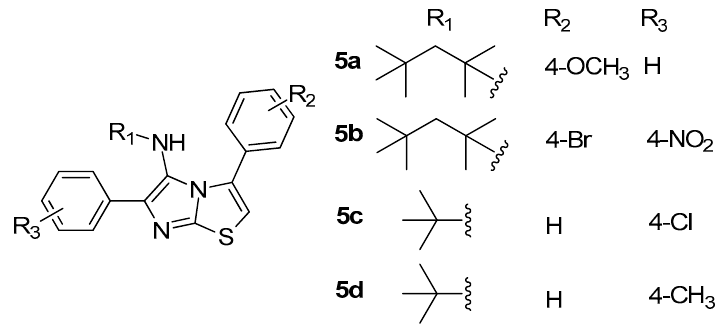
Figure 6. Chemical structures of 3,6-diphenylimidazo[2,1-b]thiazol-5-amine derivatives 5a – 5d . Elachkar et al. [77] designed and synthesized two novel thiazole derivatives (Figure 7), namely compound 6a (N-[4-(4-hydroxy-3-methoxyphenyl)-1,3-thiazol-2-yl]acetamide) and compound 6b (4-(2-amino-1,3-thiazol-4-yl)-2-methoxyphenol), with aim to analyze their effect on COX isoforms. It was shown, using cell-stably over-expressing COX-1 and blood platelets, that compound 6a was a non-selective COX-1/COX-2 inhibitor, while 6b was a selective COX-2 inhibitor with similar IC 50 s (IC 50 s 9.01 ± 0.01 mM and 11.65 ± 6.20 mM). Furthermore, these compounds demonstrated anti-inflammatory activity according to the dorsal air pouch model of inflammation. Docking studies revealed that both compounds 6a and 6b bind to the COX-2 active site in a similar manner as celecoxib.